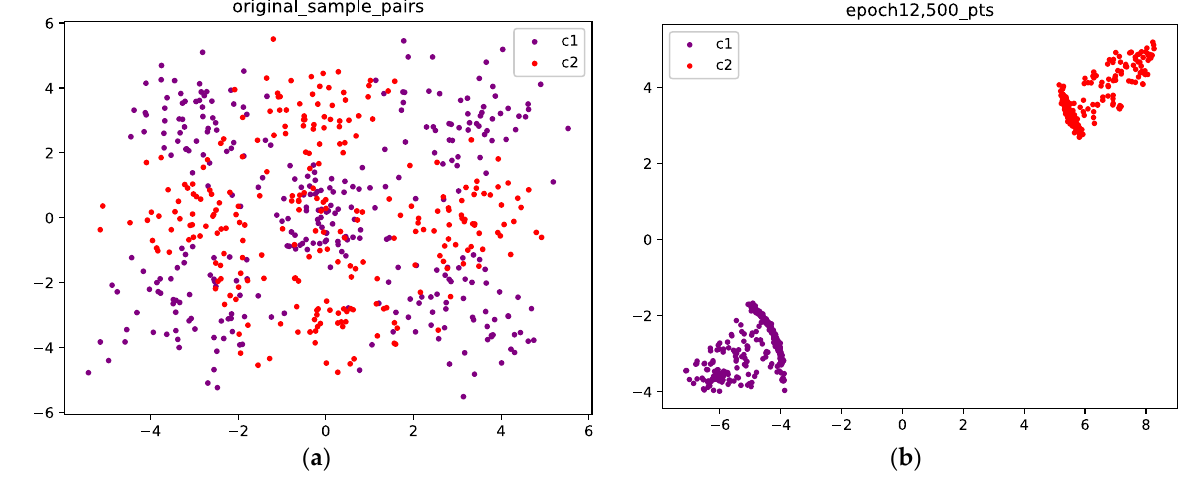
Figure 11. ( a ) The original points are sampled from a Gaussian mixture with nine components; the purple points are sampled from class 1, and the red points are sampled from class 2. ( b ) Optimized configuration after 12,500 epochs; the points from the two classes are well separated.